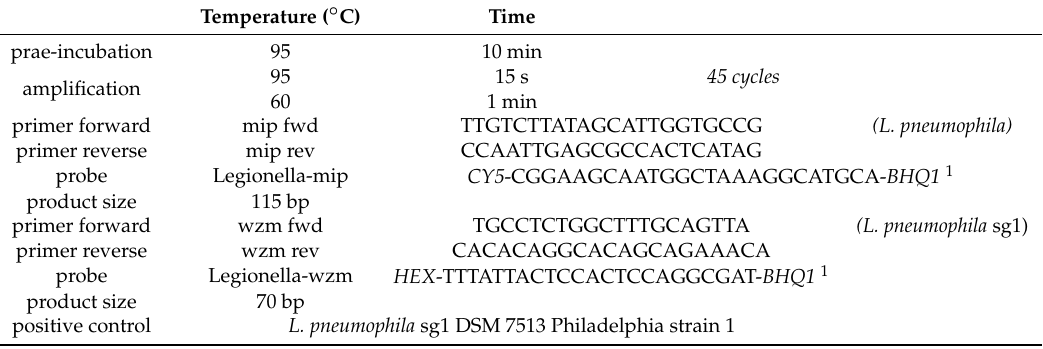
Table 1. qPCR conditions, primers and probes for L. pneumophila and L. pneumophila